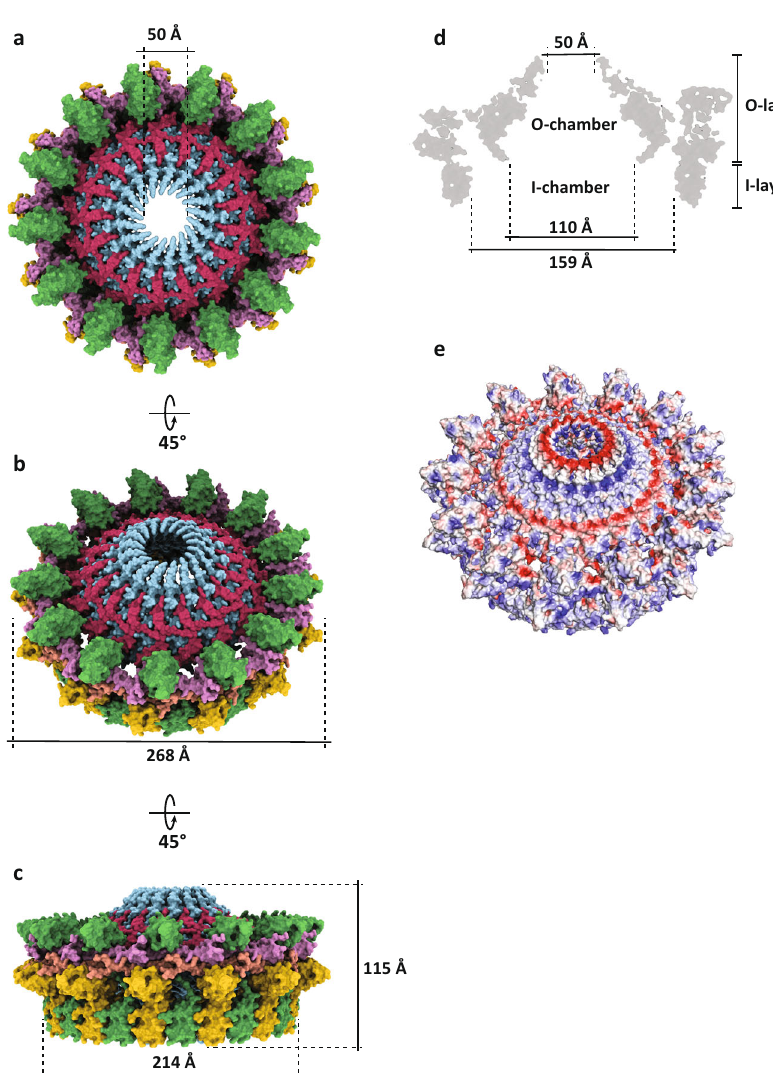
Fig. 5 Structure of the outer membrane core complex. a Top view of the structure of OMCC in surface representation with each protein within the complex coloured in their respective colours. b Tilt view of the structure in surface representation with the width of the O-layer. c Side view of the structure in surface representation with the overall height of the complex and the width of the I-layer. d Cut-away side view of the model with the dimensions at distinct positions of the inner channel and indicating speci fi c structural features within the complex. e Distribution of surface charges on the OMCC